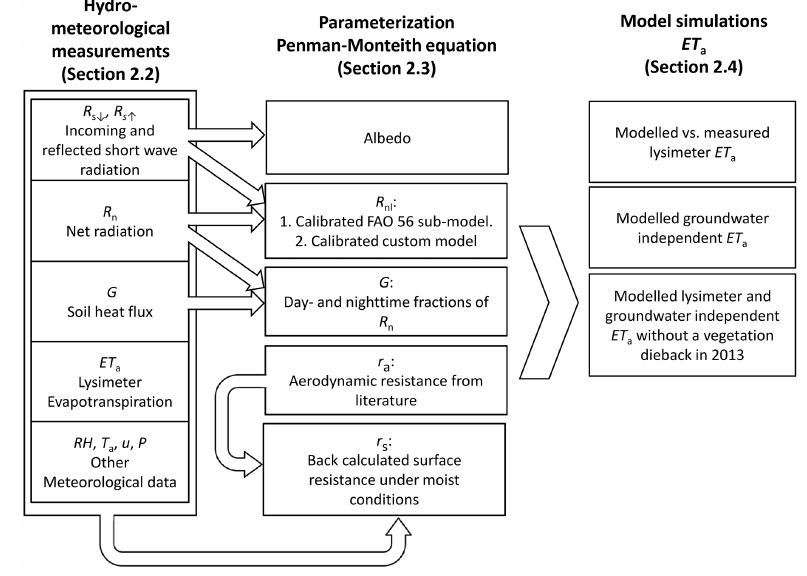
Figure 1. Organization of the research from measurements to model